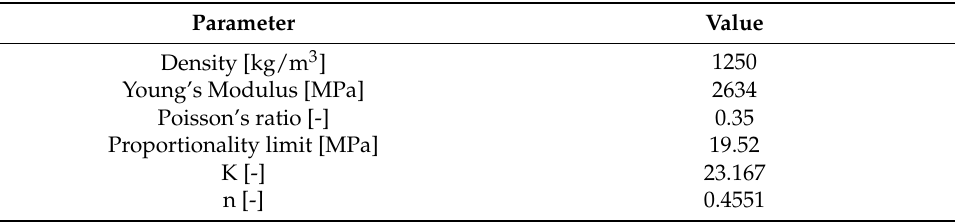
Table 4. PHBV properties used in the